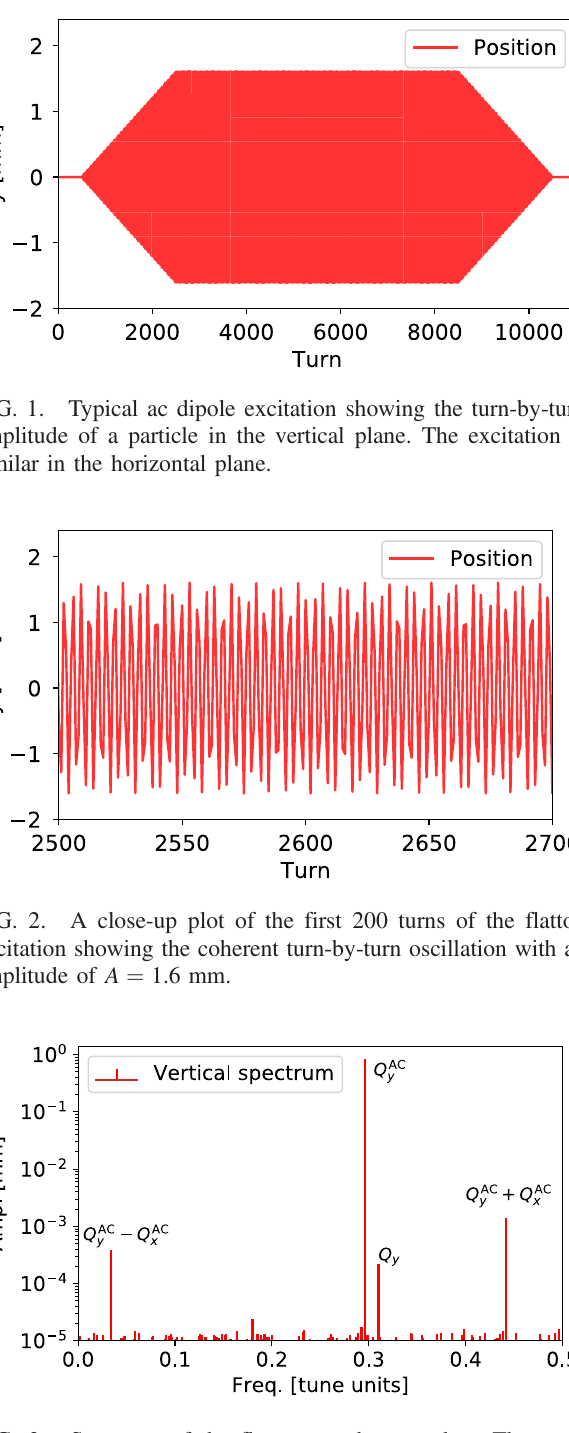
observed in the turn-by-turn data, the actions are measured from the amplitude of the tune line in the spectrum of the BPM turn-by-turn tracking data. The spectral analysis code SUSSIX [36] is used for all spectral analysis in this paper.